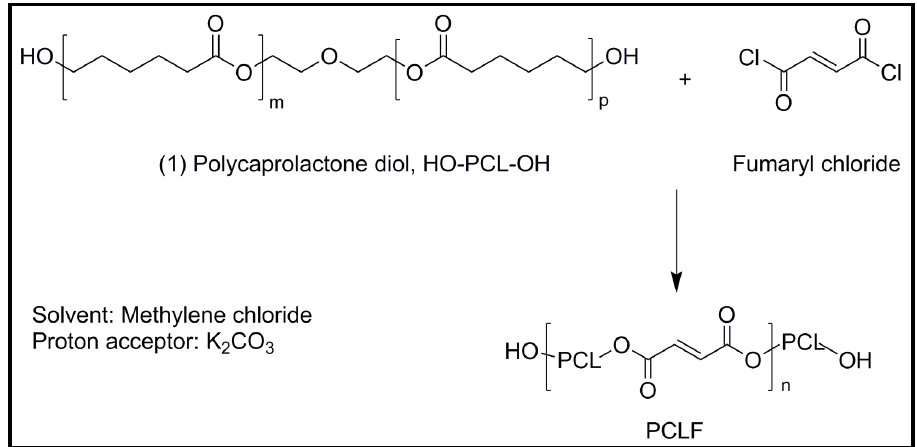
Figure 18. Chemical structure and synthesis of polycaprolactone fumarate (PCLF).